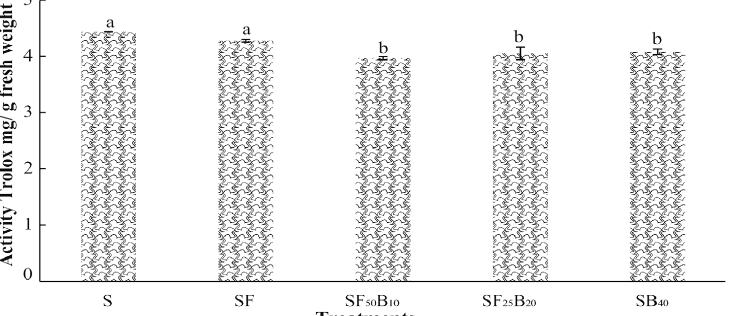
Figure 3. DPPH in basil ( Ocimum basilicum L.) cultivated in a soil with treatments, S, soil without